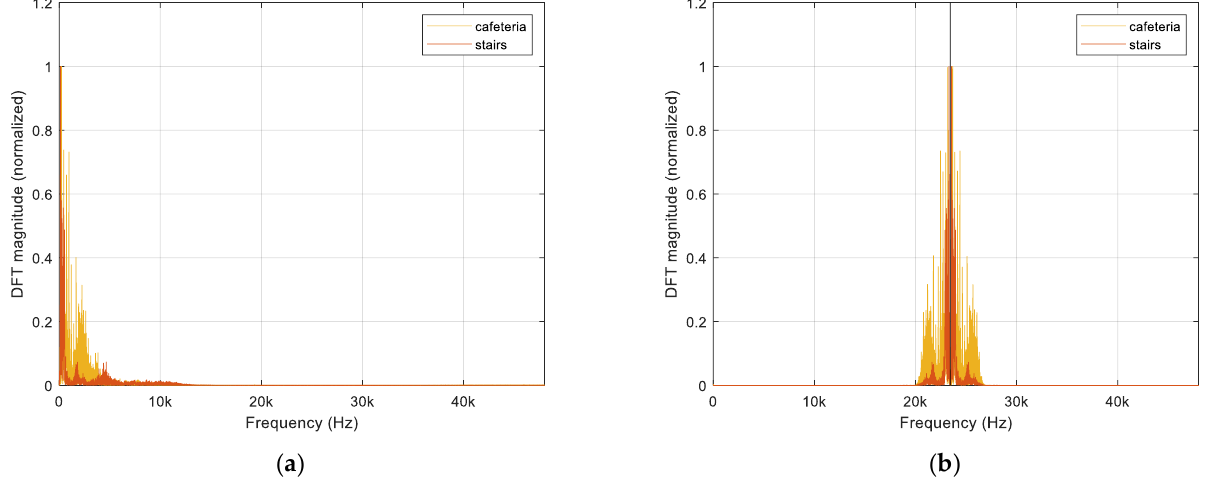
Figure 17. Normalized frequency distribution (based on discrete Fourier transform) of the signals @ 𝑓 𝑡𝑠 = 96 kHz : ( a ) Sampled signal; ( b ) Band limited and frequency shifted signal @ 𝑓 𝑚 = 46.875 2⁄ kHz and 𝑓 𝑐 = 3.4 kHz .